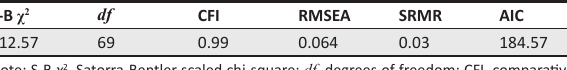
TABLE 2: Goodness-of-fit statistics of the structural model.